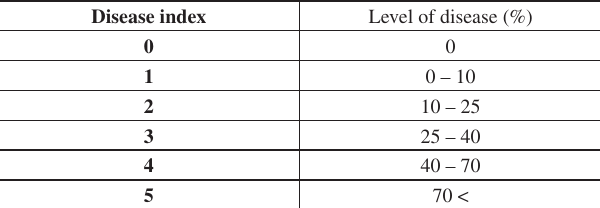
Table 1: Disease index for assessing cheryy leaf spot incidence Disease index